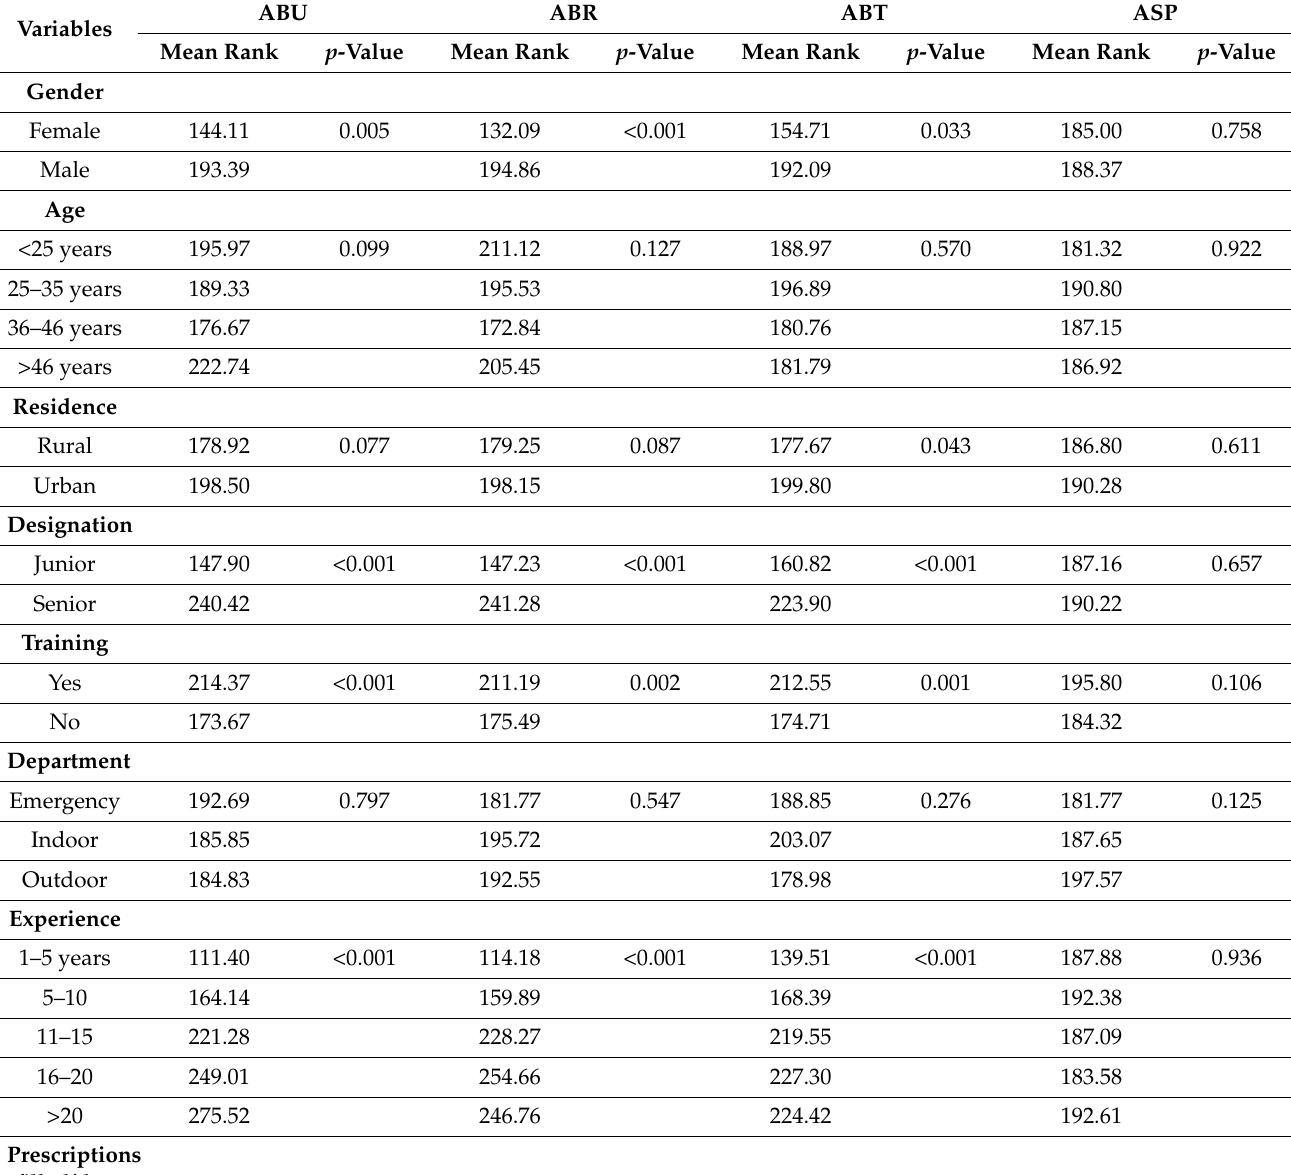
Table 6. Test of statistical significance of variation in the pharmacy technicians’ understanding towards ABU, ABR, ABT, and ASP by their